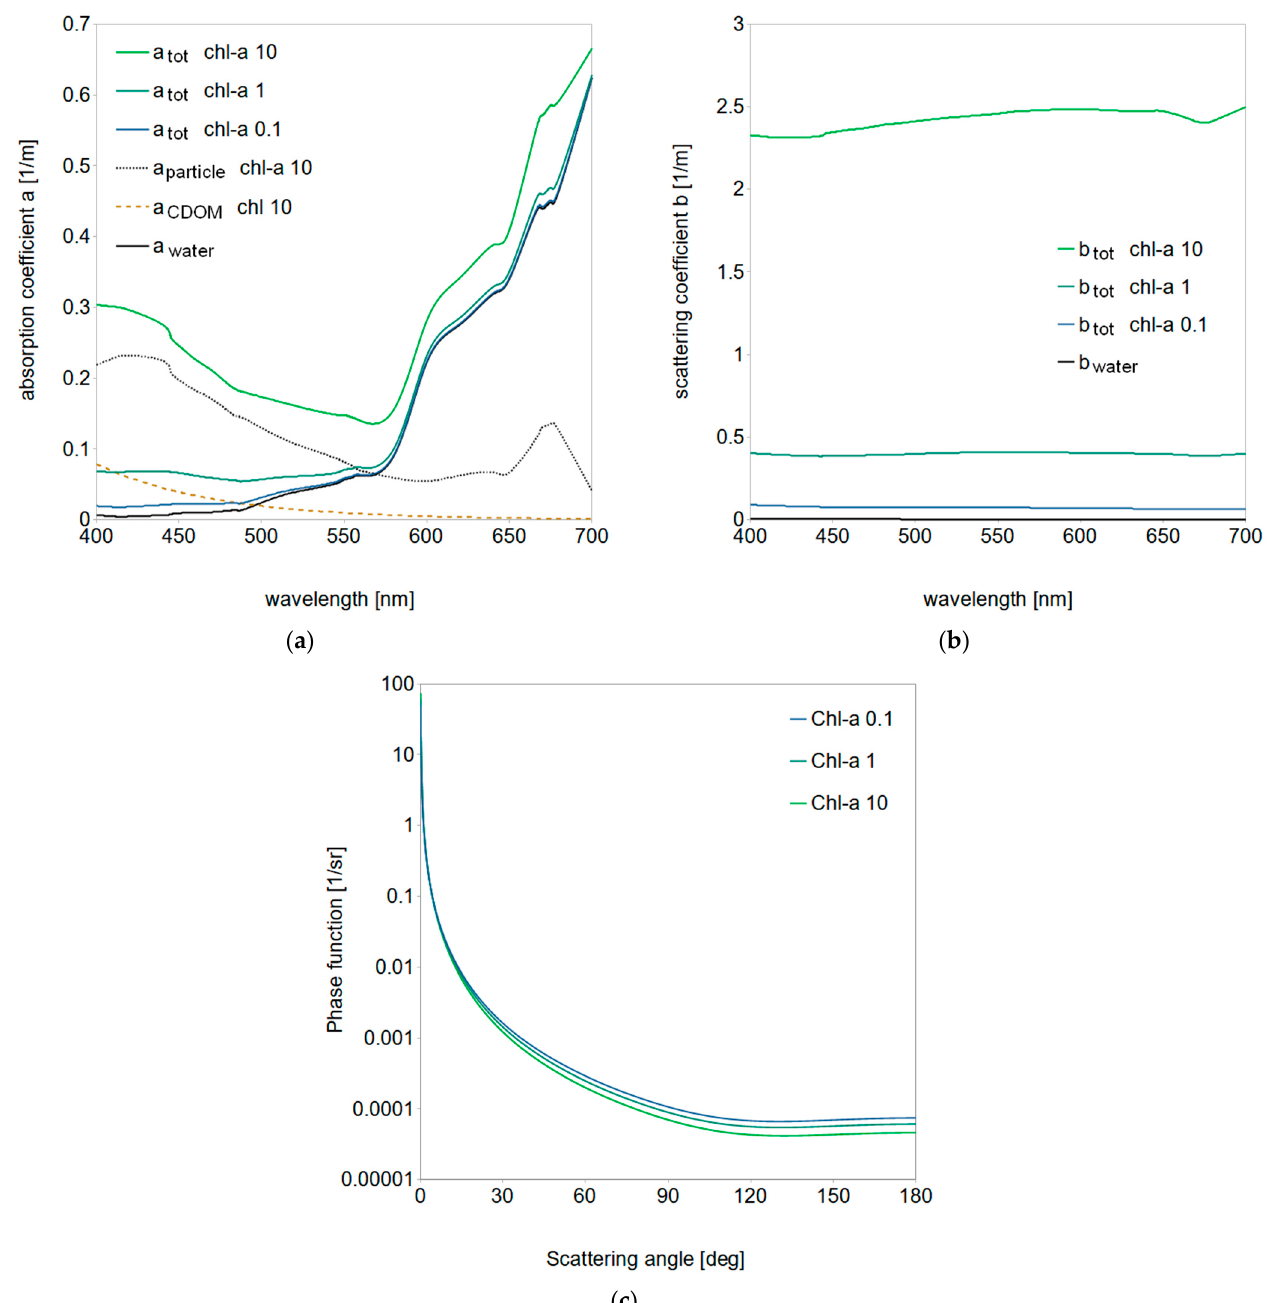
Figure 1. Inherent optical properties for oceanic water model characterized by chlorophyll-a concentrations of 0.1, 1 and 10 mg/m 3 : ( a ) total absorption coefficients a tot for three types of oceanic waters and the absorption contribution coming from chlorophyll particles, a particle , color-dissolved organic matter, a CDOM , and pure water, a water , for chl-a of 10 mg/m 3 ; ( b ) total scattering coefficients for three types of oceanic waters b tot and for pure water b water ; ( c ) log-linear plot of corresponding scattering phase functions at 555